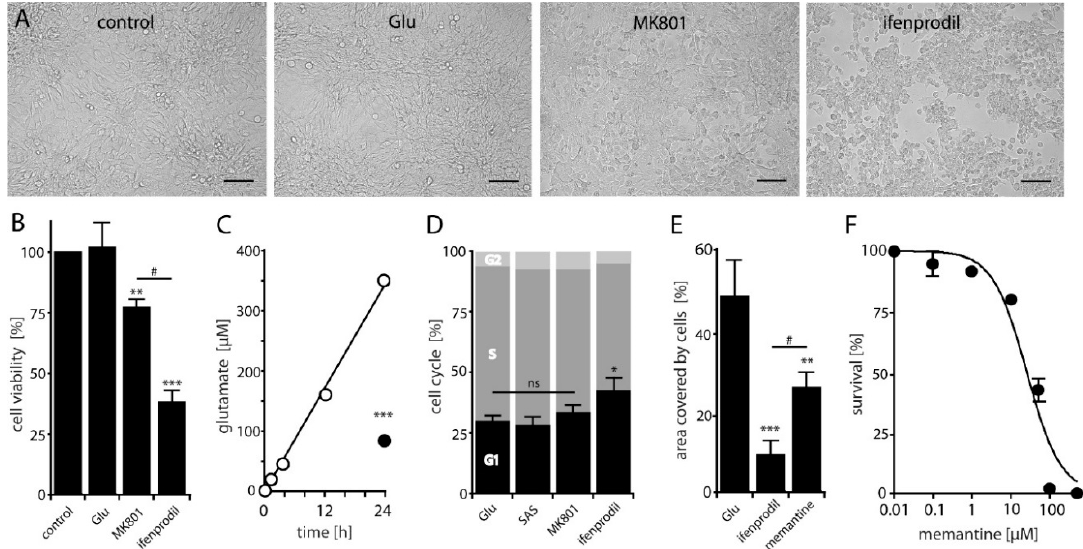
Figure 2. Effects of glutamate on LN229 cell viability, cell cycle distribution and migration. ( A ) Light microscope images of untreated cells (control), and in the presence of Glu (1 mM), MK801 (10 µM) and ifenprodil (25 µM). Scale bar 100 µm. ( B ) Cell viability measured after 48h by the MTT assay after Glu (1 mM), MK801 (10 µM) and ifenprodil (25 µM) treatment compared to control (untreated cells). The experiments were repeated at least five times performed in octuplet and values represent means ± SEM (one-way ANOVA followed by Bonferroni’s post-hoc test, ** p < 0.01, *** p < 0.001, # p < 0.05). ( C ) Increase in extracellular Glu concentrations of 3.5 × 10 5 seeded cells at indicated time points (white circles) and after treatment with sulfasalazine (SAS, 250 µM, black circle) revealed a release of ~7.8 µg/mL Glu/h. Data are expressed as means ± SEM of three independent experiments performed in triplicate. Asterisks indicate a significant difference between treated and untreated cells as determined by Student’s t -test (*** p < 0.001). ( D ) Cell cycle distribution after 24h in the presence of